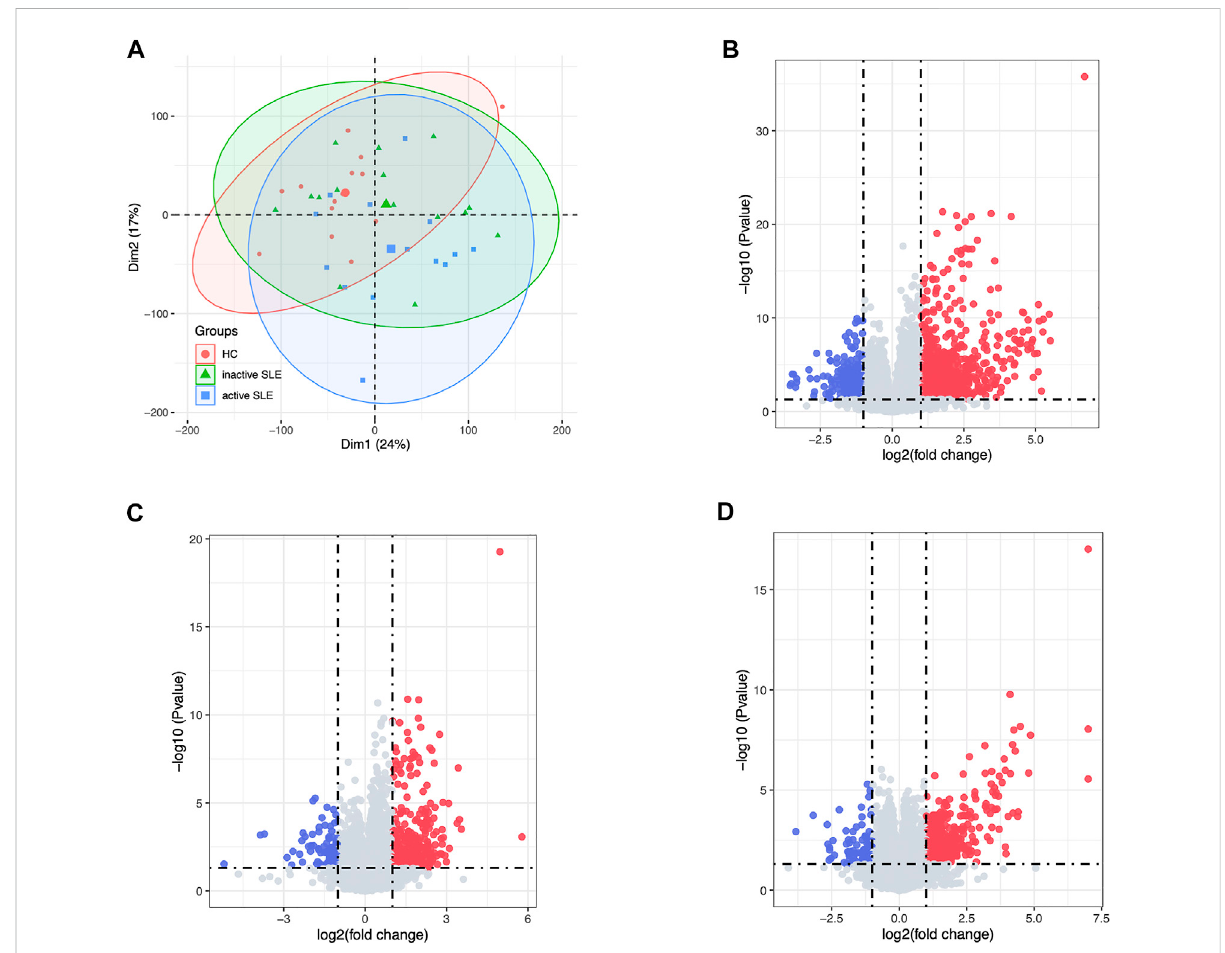
FIGURE 2 The DEG analysis showed the differences of gene expression pro fi les in HC, inactive and active SLE patients. (A) The PCA result of the gene expression of CD4 + T cells in HC, inactive and active SLE patients. (B – D) The volcano plot of DEGs between HC and active SLE (B) , HC and inactive SLE (C) , and inactive SLE and active SLE (D)